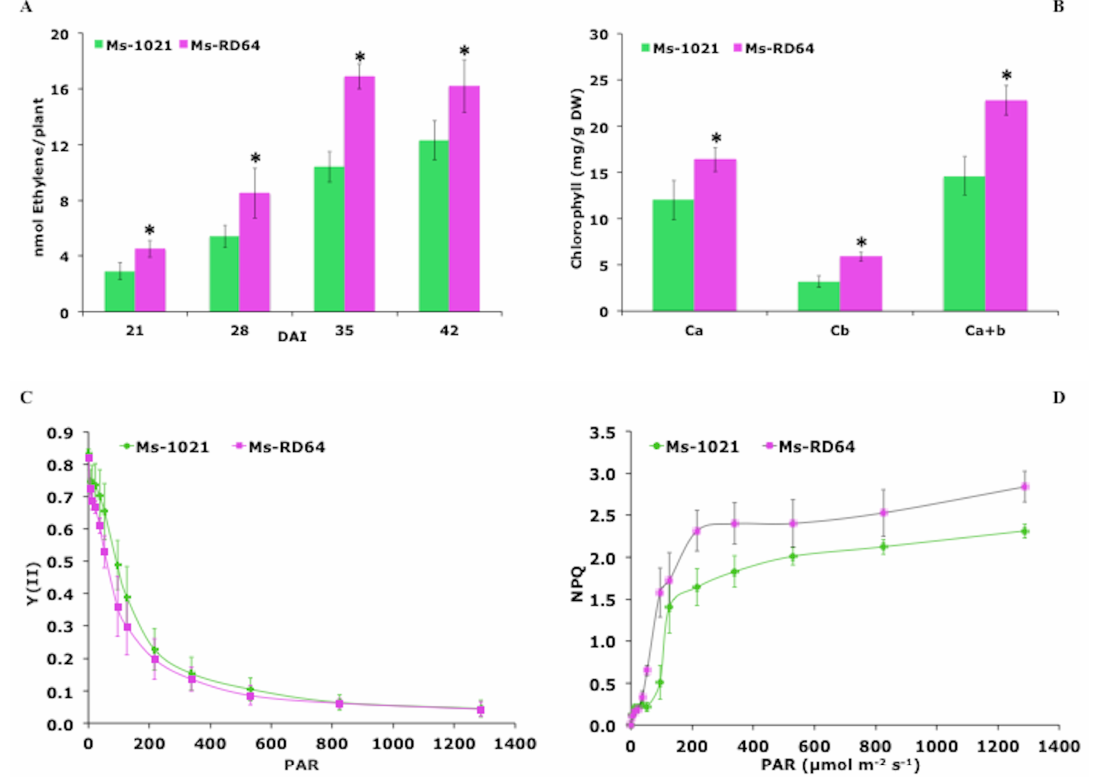
Figure 2. Medicago plants nodulated by the IAA-overproducing Ensifer meliloti RD64 show significant changes in nitrogenase activity, chlorophyll content, and light-induced non-photochemical quenching (NPQ) generation. ( A ) The activity of the nitrogenase enzyme was measured by the acetylene reduction assay (ARA) on root sections of nodulated Medicago plants harvested at different times after inoculation. Data presented are the mean ± SD of at least five replicates. ( B ) Chlorophyll content extracted from leaves at 42 days after infection (DAI). ( C ) Light-dependent changes of the effective PSII quantum yield [Y(II)] for dark-adapted plant leaves at 42 DAI. ( D ) NPQ for dark-adapted plants leaves at 42 DAI. Data presented are the mean ± SD of six biological replicates. The asterisks in panel A and B indicate significant differences ( P < 0.05, one-way ANOVA with Tukey’s post-hoc test) between 1021- and RD64-nodulated plants.